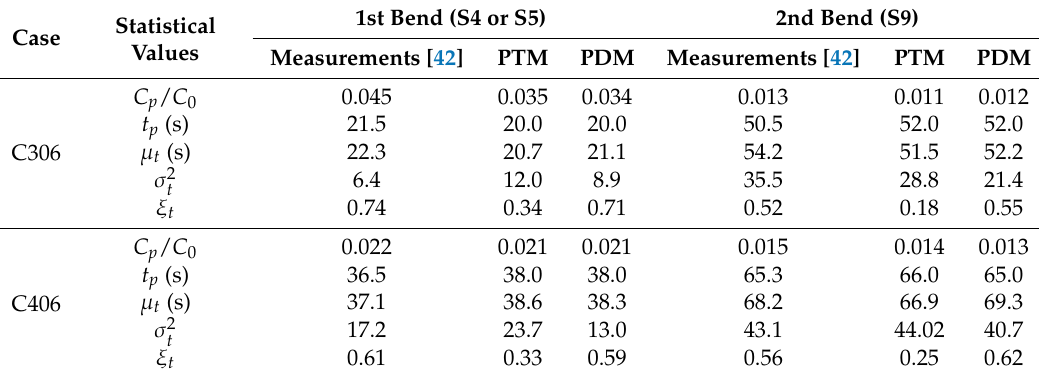
Table 3. Statistical properties of concentration curves in channel